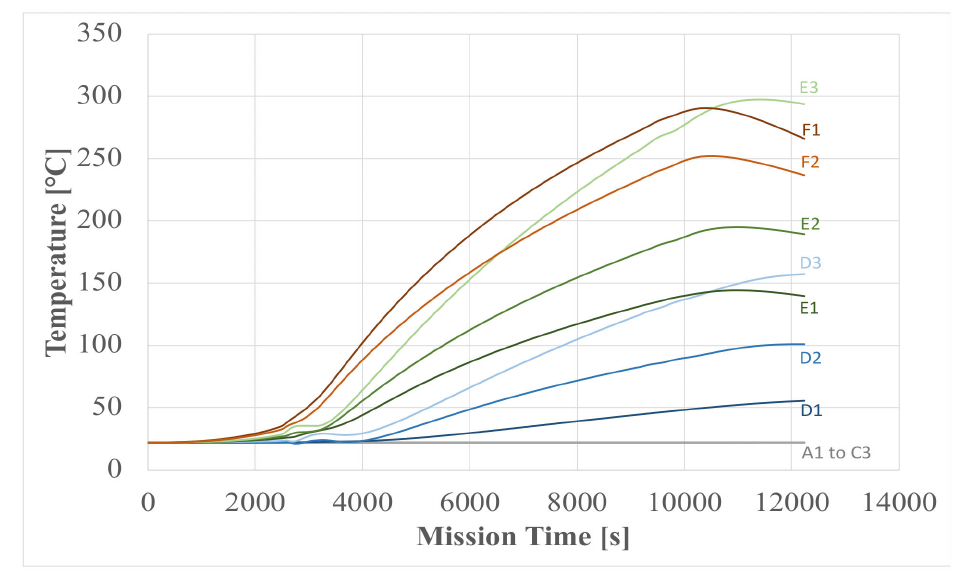
Figure 13. Temperature profiles insisting on top of the passenger cabin and due to the presence of the propulsive flow-path ( T eng